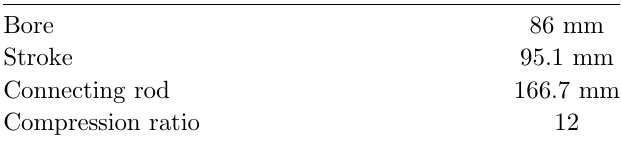
Fig. 4. Sandia DISI engine: cross-sectional view of the com- bustion chamber. The valves, pent roof, spark plug and injector location and orientation are visible. Table 1. DISI engine dimensions.